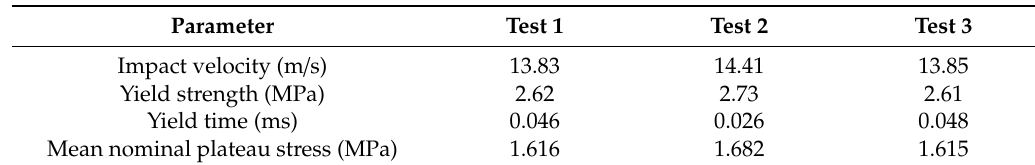
Table 2. Impact test results of three tests.